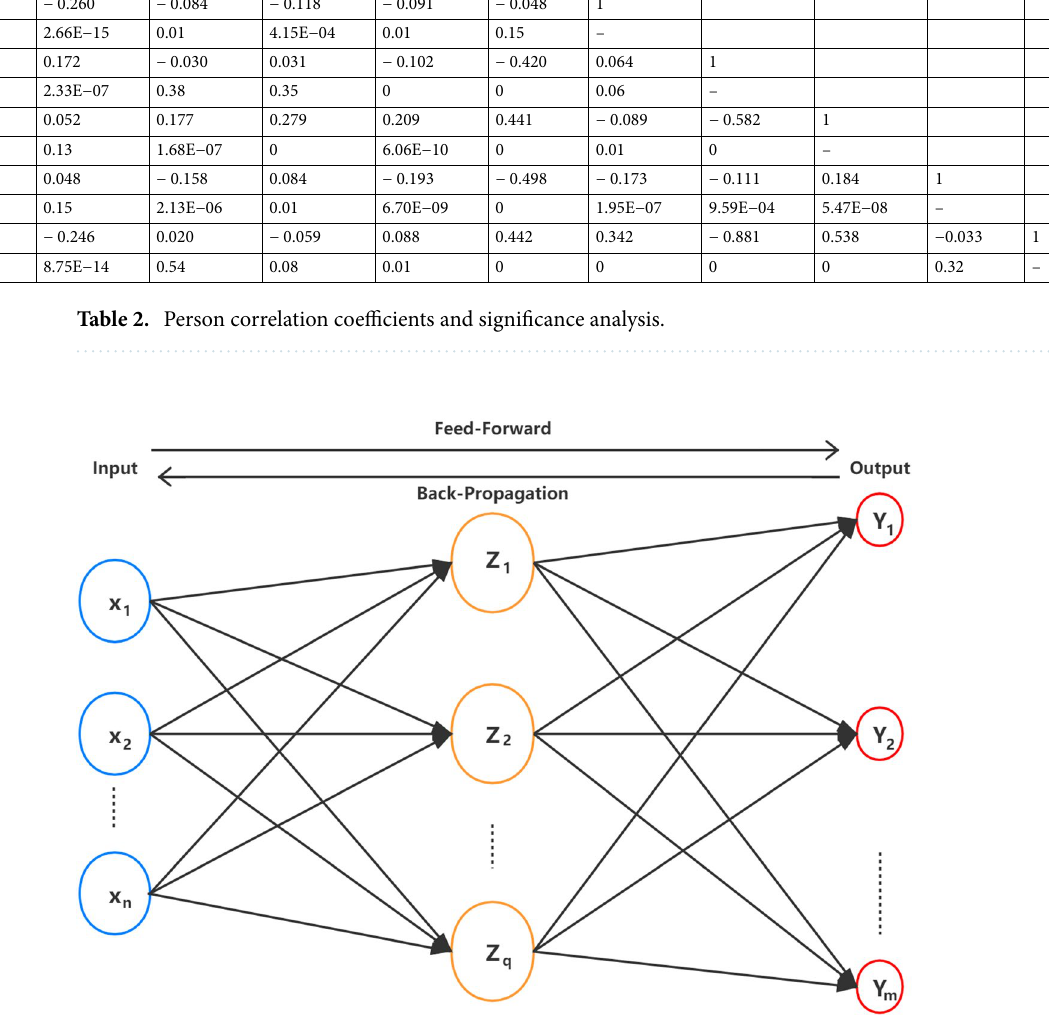
Figure 2. Topology of neural network.Fig. 1. This figure shows the basic structure of the neural network